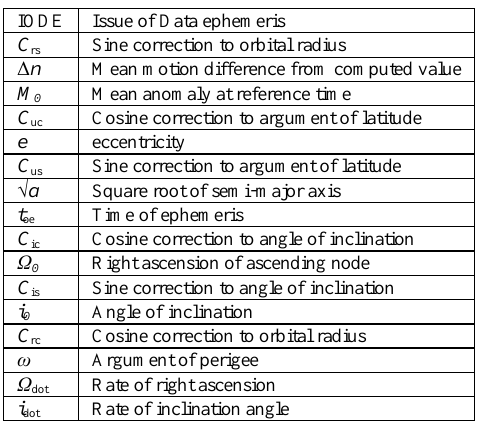
Table 1. Ephemeris data